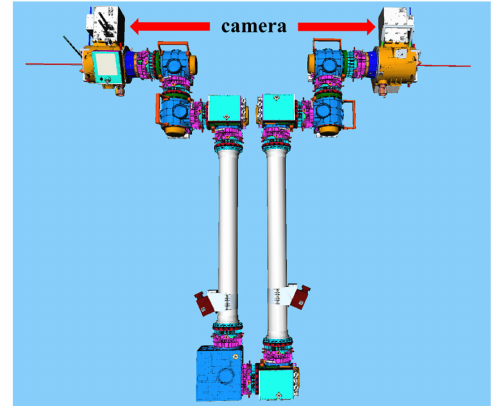
Figure 3. Position of the camera in the